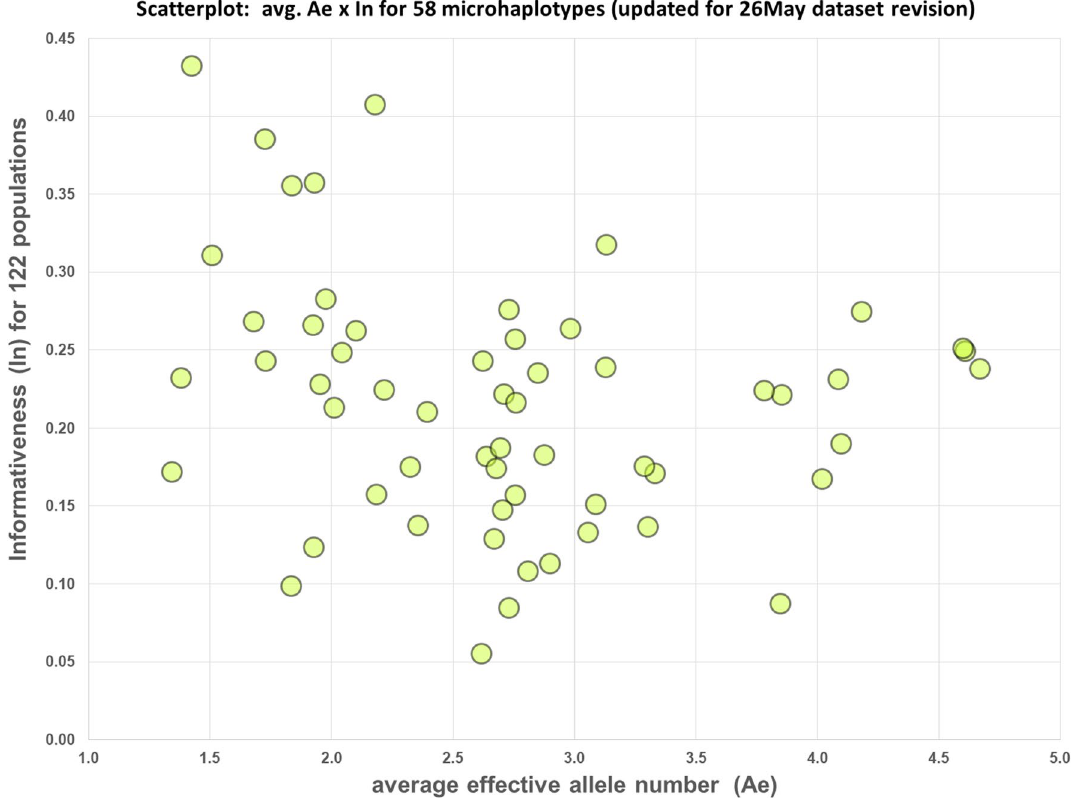
Figure 1. Scatterplot of A e by I n for 58 microhaps evaluated on 122 populations. See